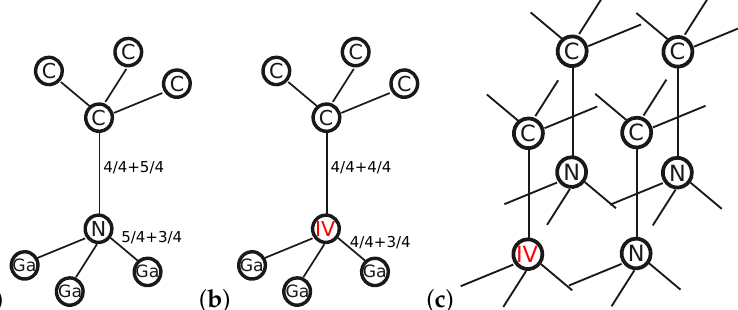
Figure 13. Scheme of long tetrahedral bonds with fractions of the valence electron charge at the ( a ) abrupt N-C diamond–GaN interface type. ( b ) Supplemental configuration with a IV-valency atom substituting the N atom. ( c ) Reconstructed N-C diamond–GaN interface type with a IV-valency substitutional atom in a surface 2 × 2 unit